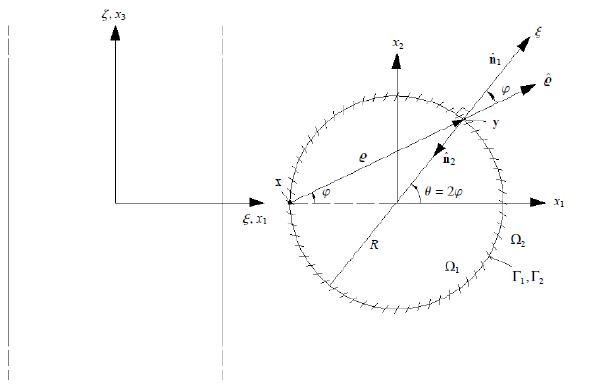
Figure 2. Geometry of the monopile foundation, Cartesian and polar coordinate